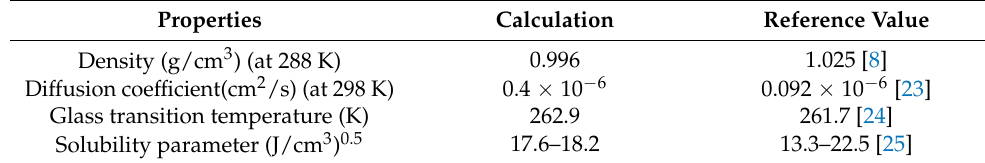
Table 2. Calculation and reference values of properties of bitumen all-atom molecular